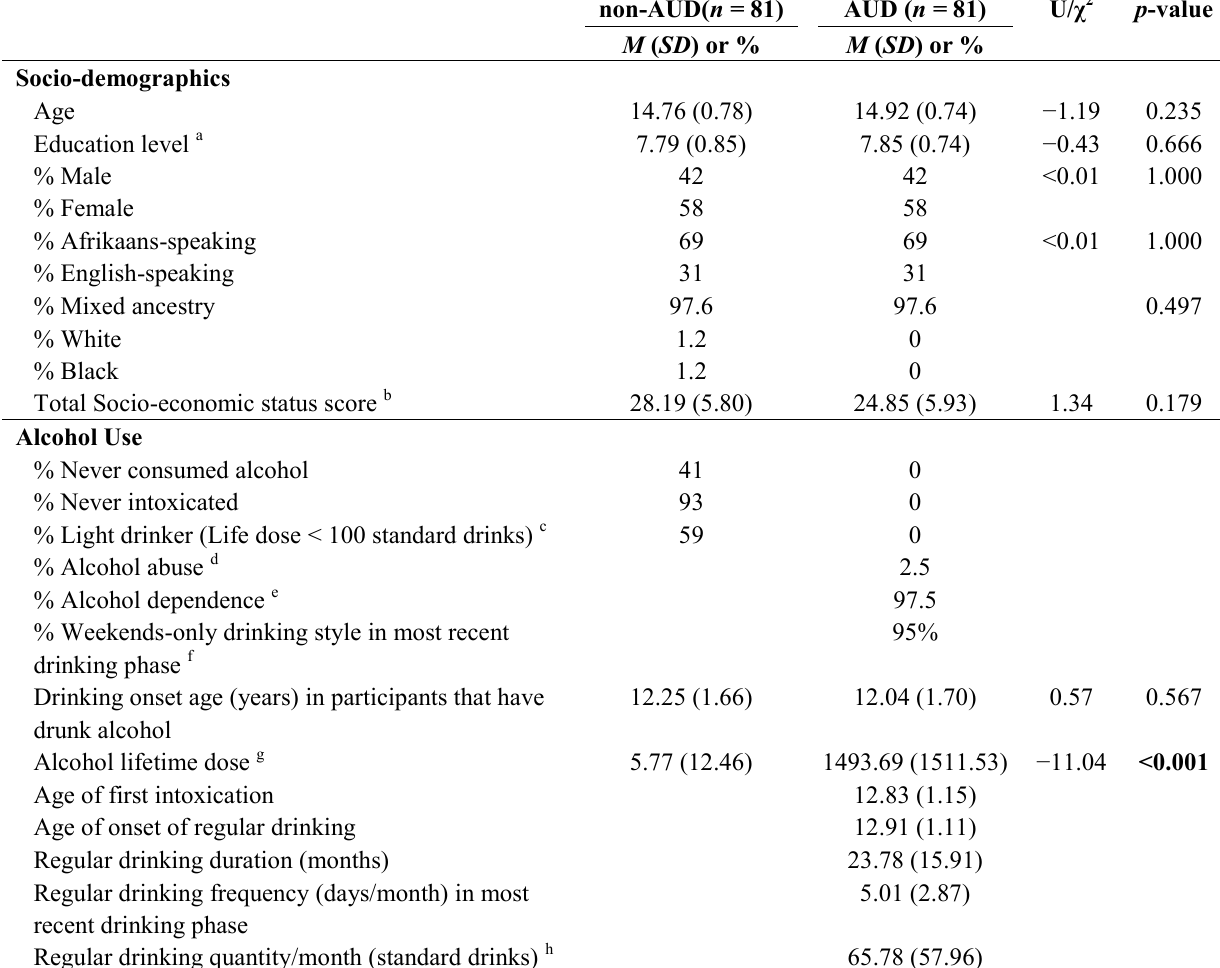
Table 1. Confirmatory analyses of socio-demographic and alcohol grouping measures and substance use characteristics of the non-AUD and AUD